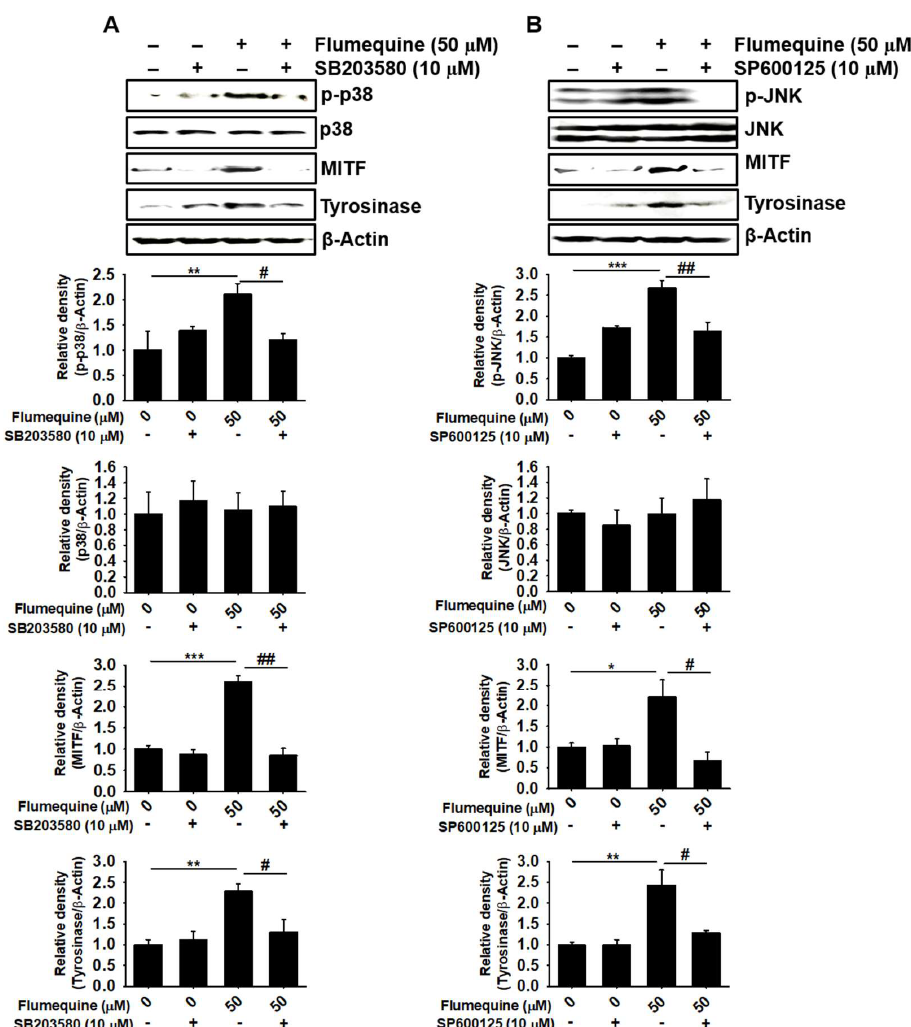
Figure 7. p38 MAPK and JNK upregulate flumequine-mediated melanogenesis in B16F10 cells by activating MITF and tyrosinase. B16F10 cells were pretreated with ( A ) SB203580 (10 μM) or ( B ) SP600125 (10 μM) for 1 h, and then flumequine (50 μM) was treated for 72 h. Expression of p38, JNK, MITF, and tyrosinase was measured by western blotting analysis. Each relative density was normalized by the density of β-Actin. The results are the average of three independent experiments and are represented as the mean ± SEM. *** , p < 0.001, ** , p < 0.01, and *, p < 0.05 vs. untreated control, and ## , p < 0.01, # , p < 0.05 vs. flumequine-treated group.